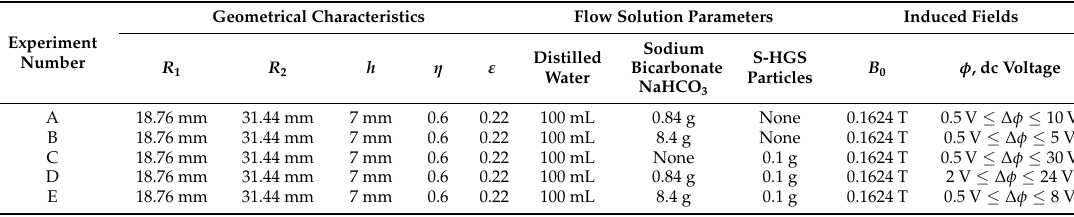
Table 1. Experiment description.